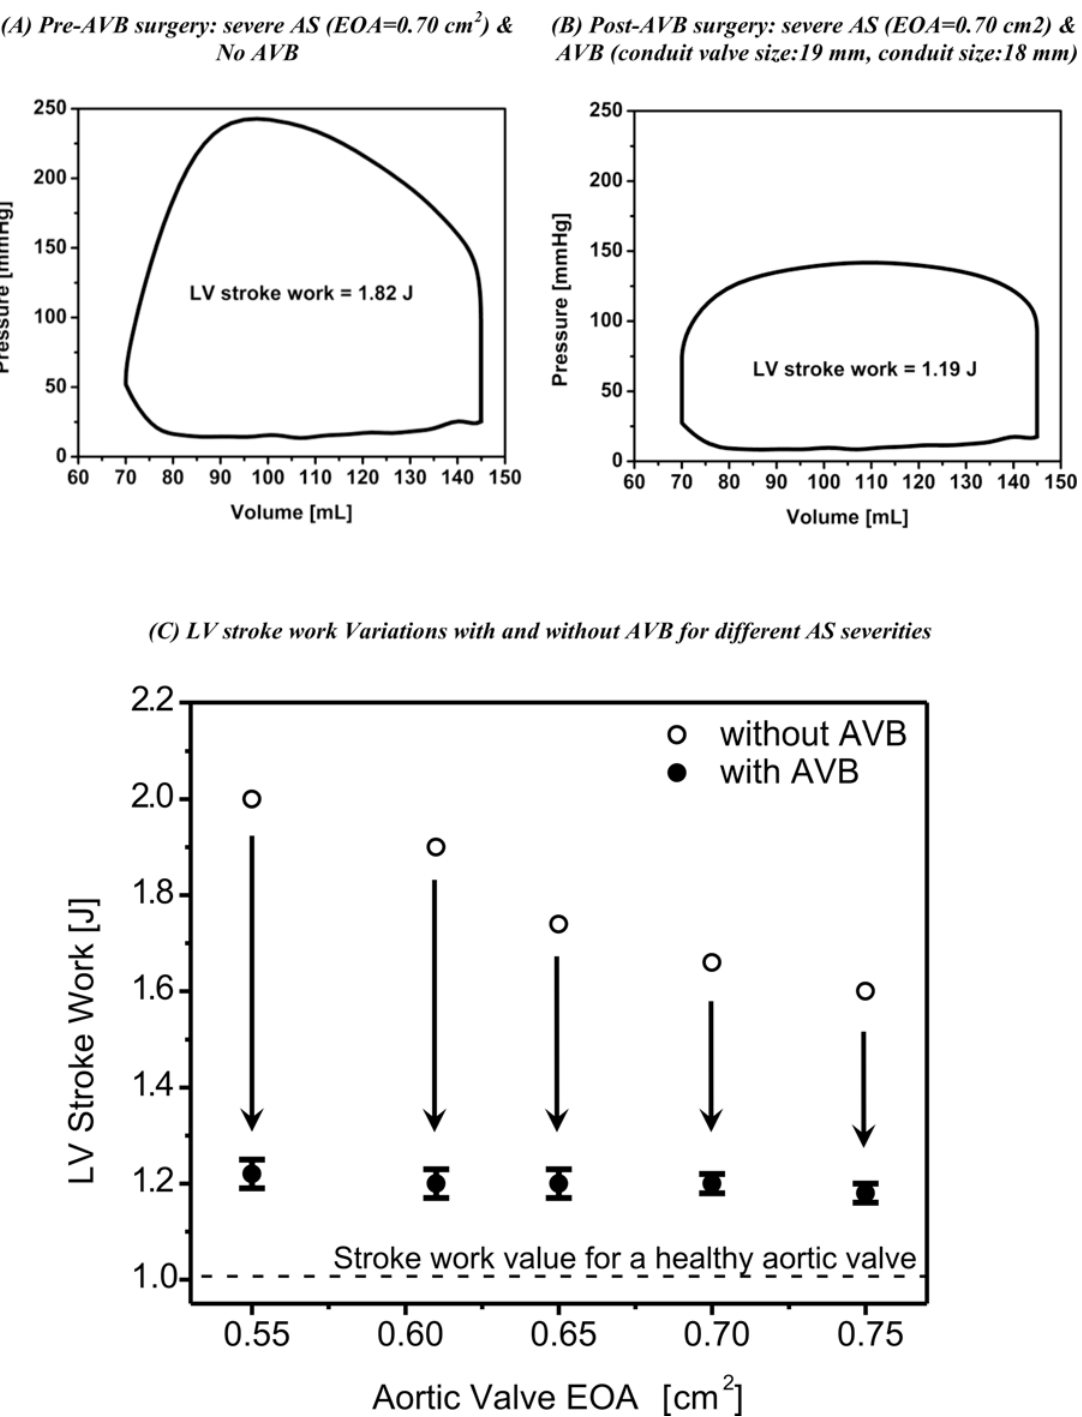
Fig 4. Simulated LV stroke work. (A) Pre-AVB surgery for a severe AS (EOA = 0.7 cm 2 ), (B) post-AVB surgery with a conduit valve size of 19 mm and a conduit size of 18mm, (C) LV stroke work variations with and without AVB for different AS severities. The values are averaged over the all configurations for AVB in terms of conduit and valves sizes simulated in this